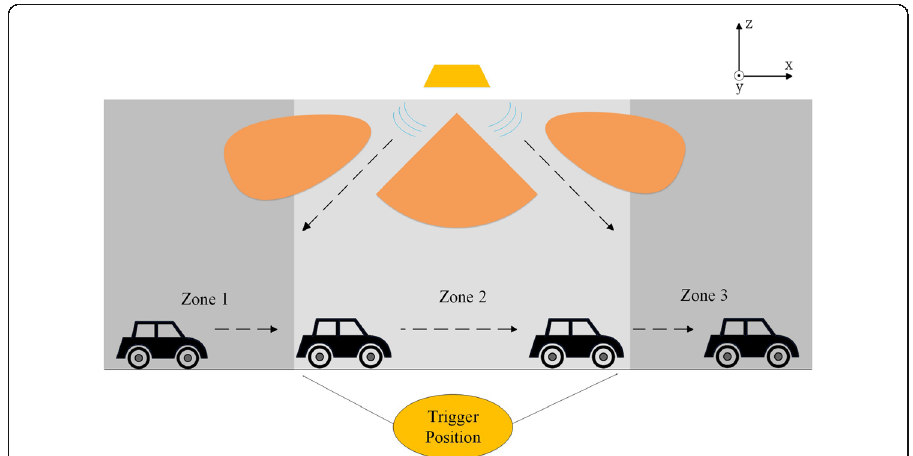
Fig. 1 Operation diagram of the smart